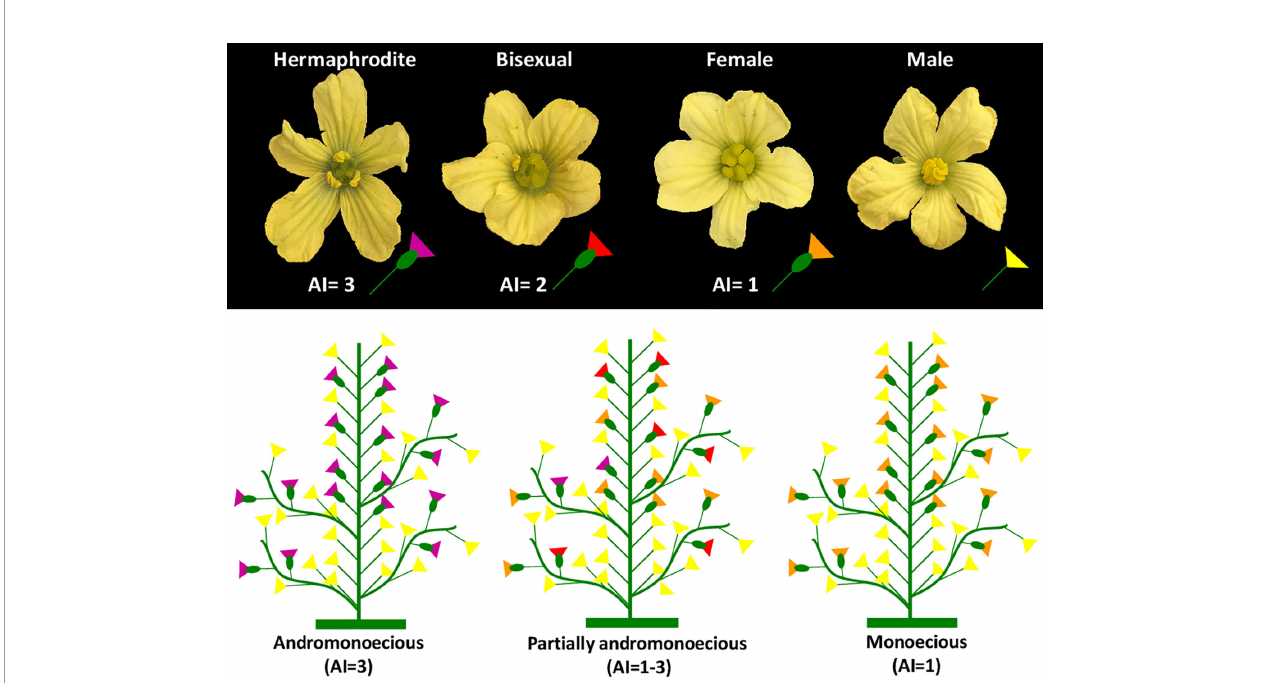
FIGURE 1 | Types of fl owers and sex morphotypes in watermelon: monoecious, andromonoecious and partially andromonoecious. Flowers are classi fi ed as male (only stamens), female (only carpels), bisexual (producing carpels and some undeveloped stamens) and hermaphrodite (producing both mature carpels and mature stamens with pollen). The Andromonoecious Index (AI) was used to estimate the level of andromonoecy of each plant and accession. For this, female, bisexual and hermaphroditic fl owers were assigned the values of AI = 1, 2, and 3, respectively. The AI of each plant was calculated as the average of the AI of a minimum of 10 pistillate fl owers per plant. An AI value of 1 corresponds to plants producing only female fl owers, and a value of 3 indicates that plants produce only hermaphrodite fl